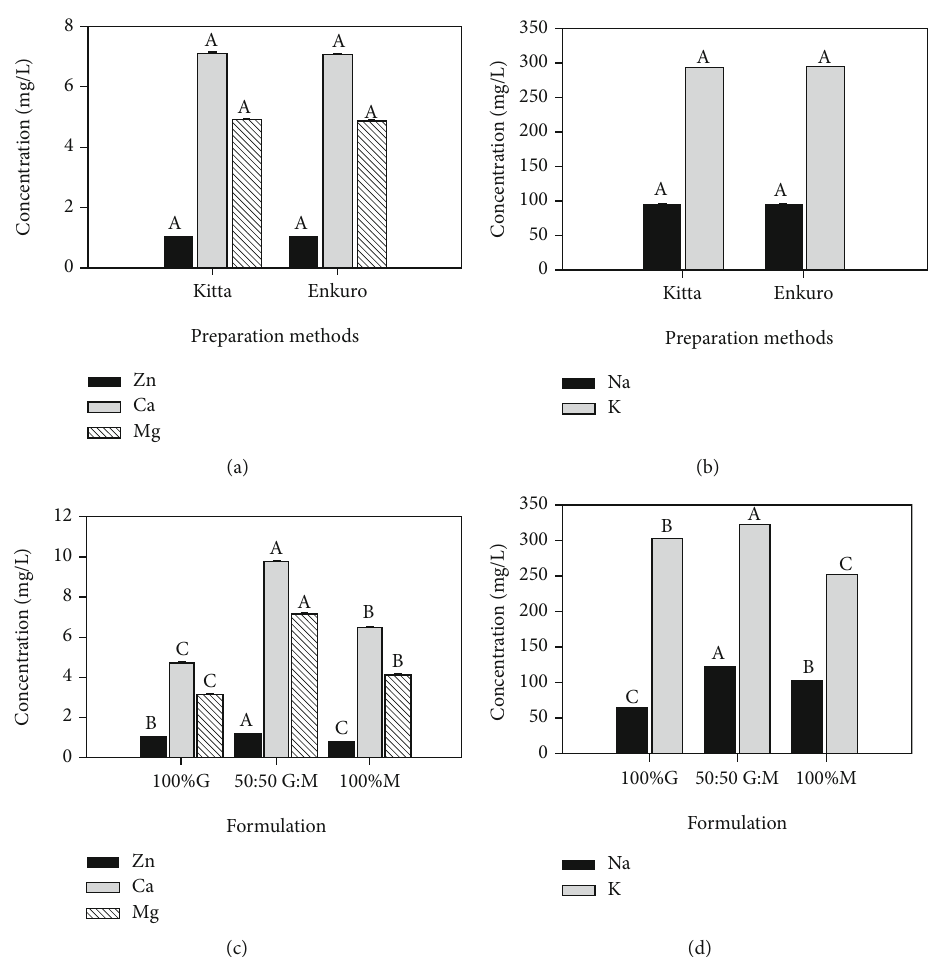
Figure 4: Mineral composition of tella for di ff erent preparations (a, b) and formulations (c, d); G: gesho ; M: moringa; values are least square means with standard errors as error bars and those with di ff erent connecting letters are signi fi cantly di ff erent ( p < 0 : 05